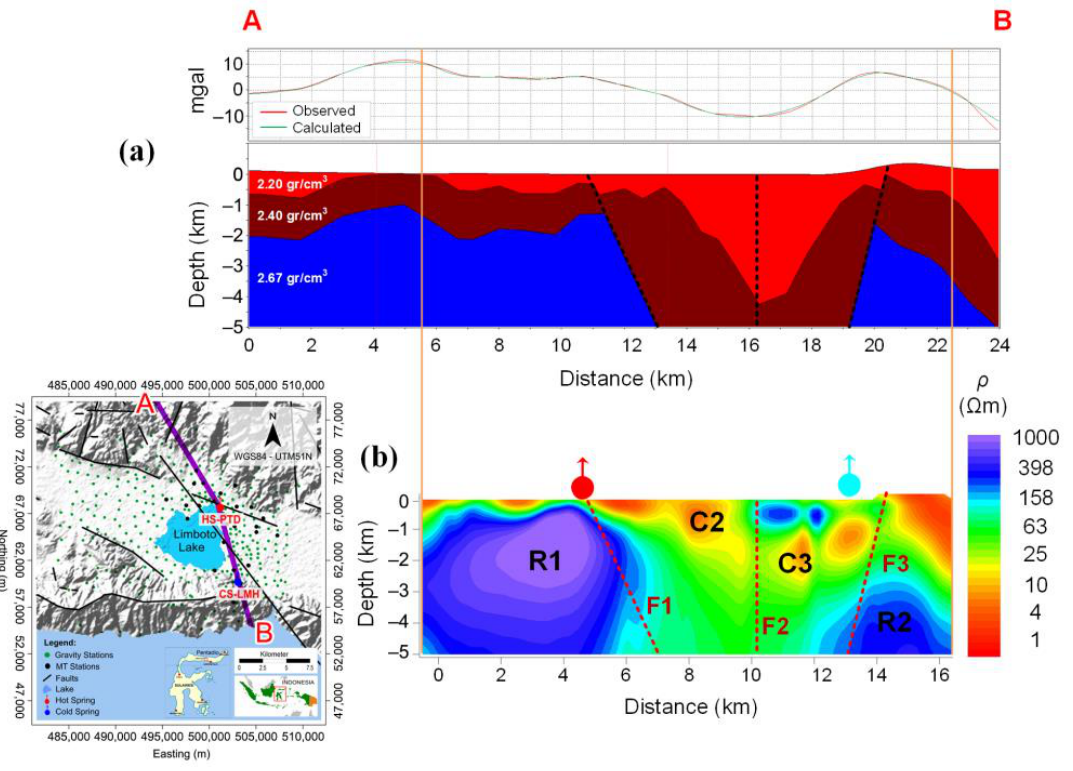
Figure 11. An integrated geophysical interpretation in sections A – B: ( a ) density model of A – B constrained by the MT result and geological studies; ( b ) incorporated 3D resistivity profile of A – B.